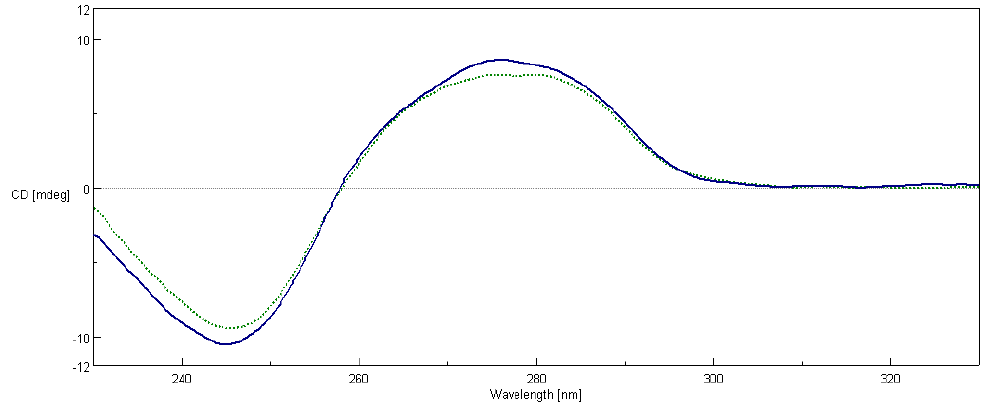
Figure 7. The circular dichroism spectra of pure ct-DNA 100 µM (solid) and ct-DNA incubated with 2a at concentration of 10 µM (dots).